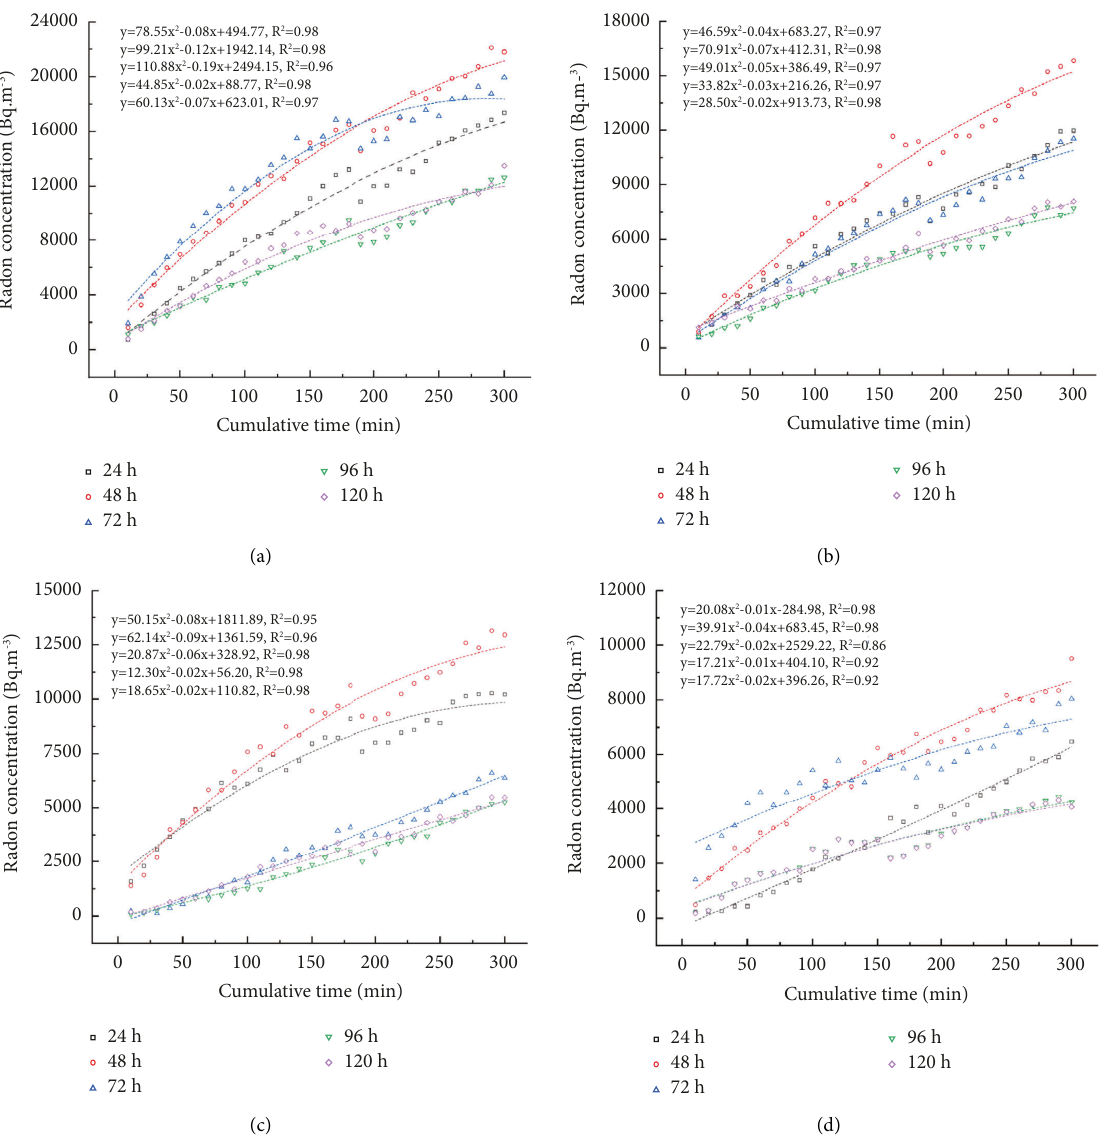
Figure 3: Cumulative radon concentration of the overburden layer with different compaction degrees. (see Figure 3(a)), compaction degree is 0.56,(see Figure 3(b)), compaction degree is 0.62, (see Figure 3(c)), compaction degree is 0.70, (see Figure 3(d)), and compaction degree is